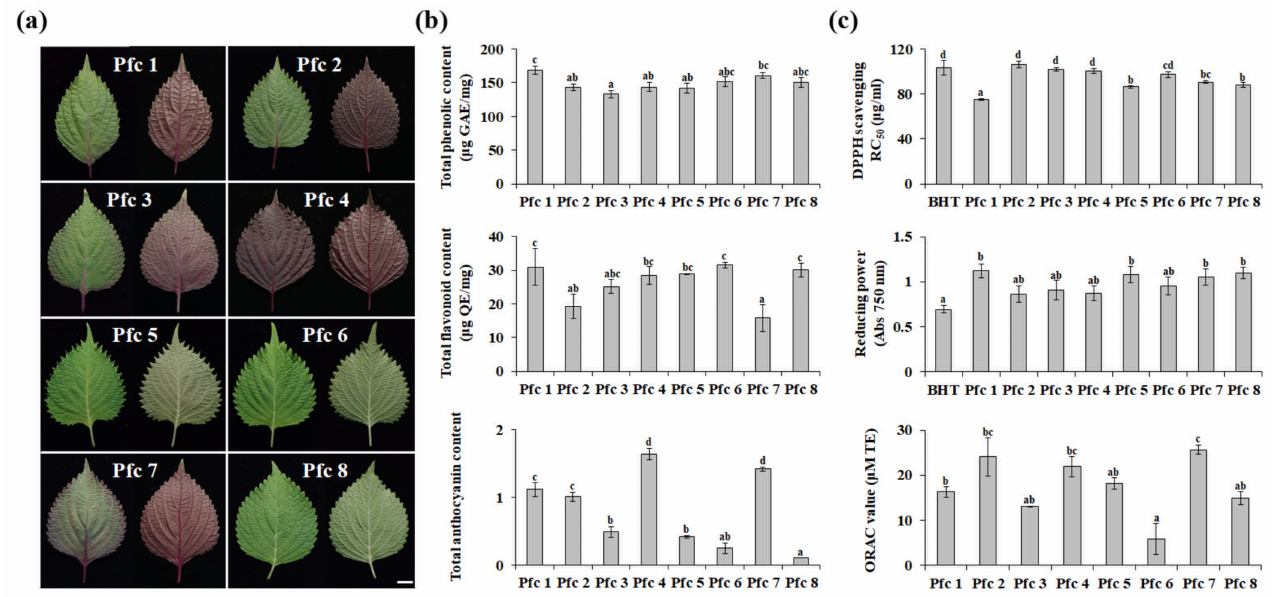
Figure 1. Effects of genotype on phytochemical concentrations and antioxidant activities. ( a ) Typical leaves of eight genotypes of Perilla frutescens var. crispa (Pfc). Scale bar = 1 cm. ( b ) Total phenolic content, total flavonoid content, and total anthocyanin content of eight Pfc genotypes. ( c ) Antioxidant activities of eight Pfc genotypes. The antioxidant activities were determined using DPPH free radical scavenging, reducing power, and ORAC assays. Different letters indicate that means are significantly difference at p < 0.05 (means ± SE of three independent